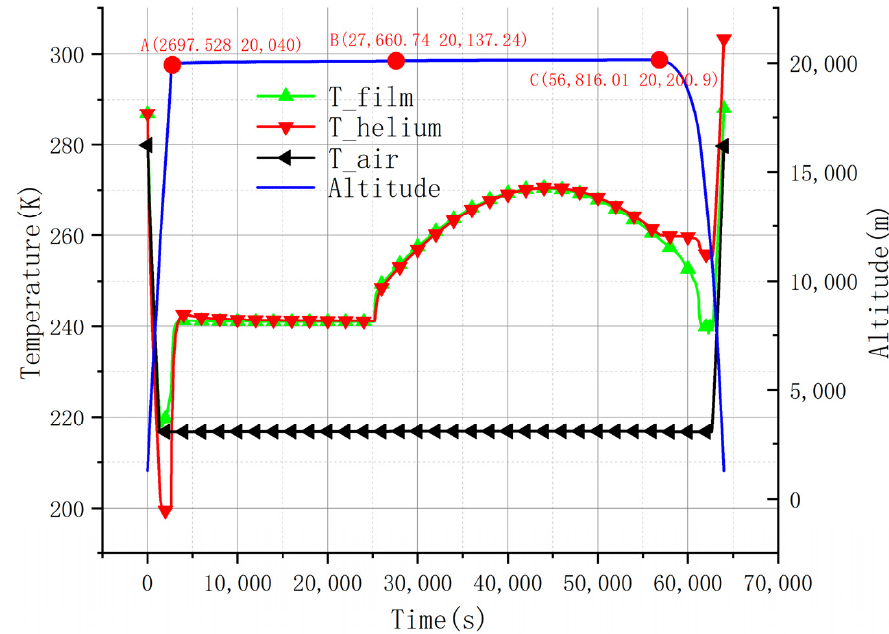
Figure 7. Temperature change of the film, helium, and air vs. time, and altitude change vs. time.